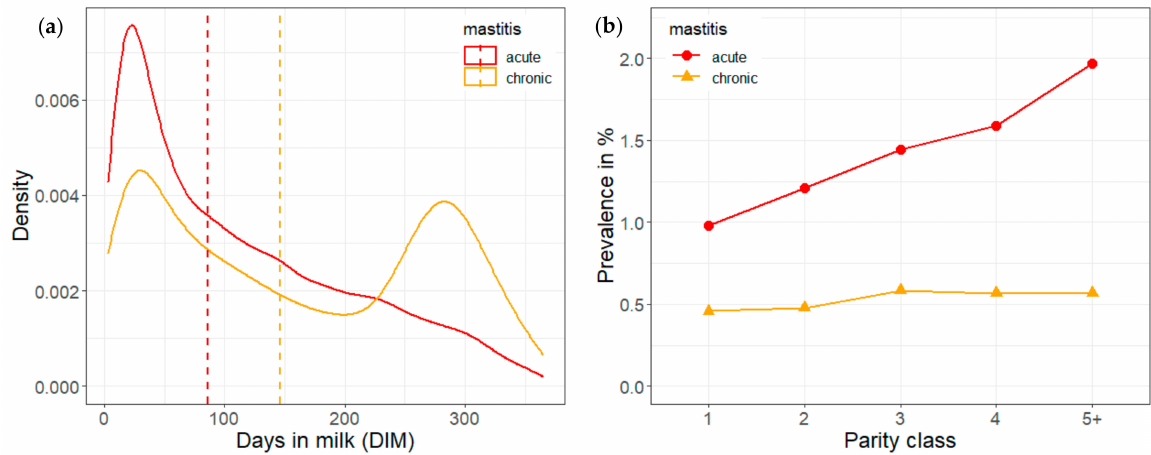
Figure 2. Distribution of test-day records linked to acute and chronic clinical mastitis diagnoses during 365 days of lactation. ( a ) Density as a function of days in milk, vertical lines indicating median values. ( b ) Incidence as a function of